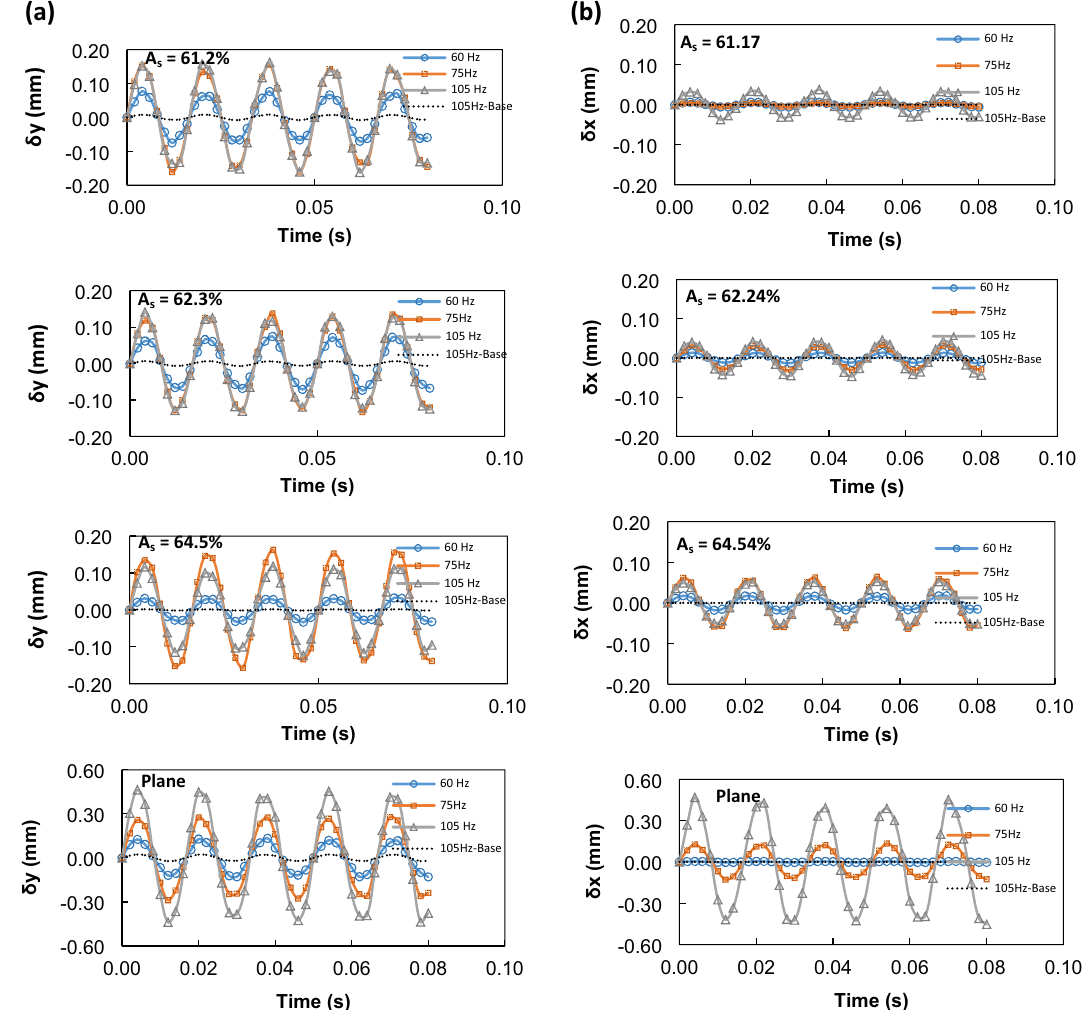
Figure 6. ( a ) Droplet maximum vertical displacement with time at different sonic excitations frequencies for different mesh screen open aperture ratio ( A s ) and plane hydrophobic surface. ( b ) Droplet maximum horizontal displacement with time at different sonic excitation frequencies for different mesh screen open aperture ratio ( A s ) and plane hydrophobic